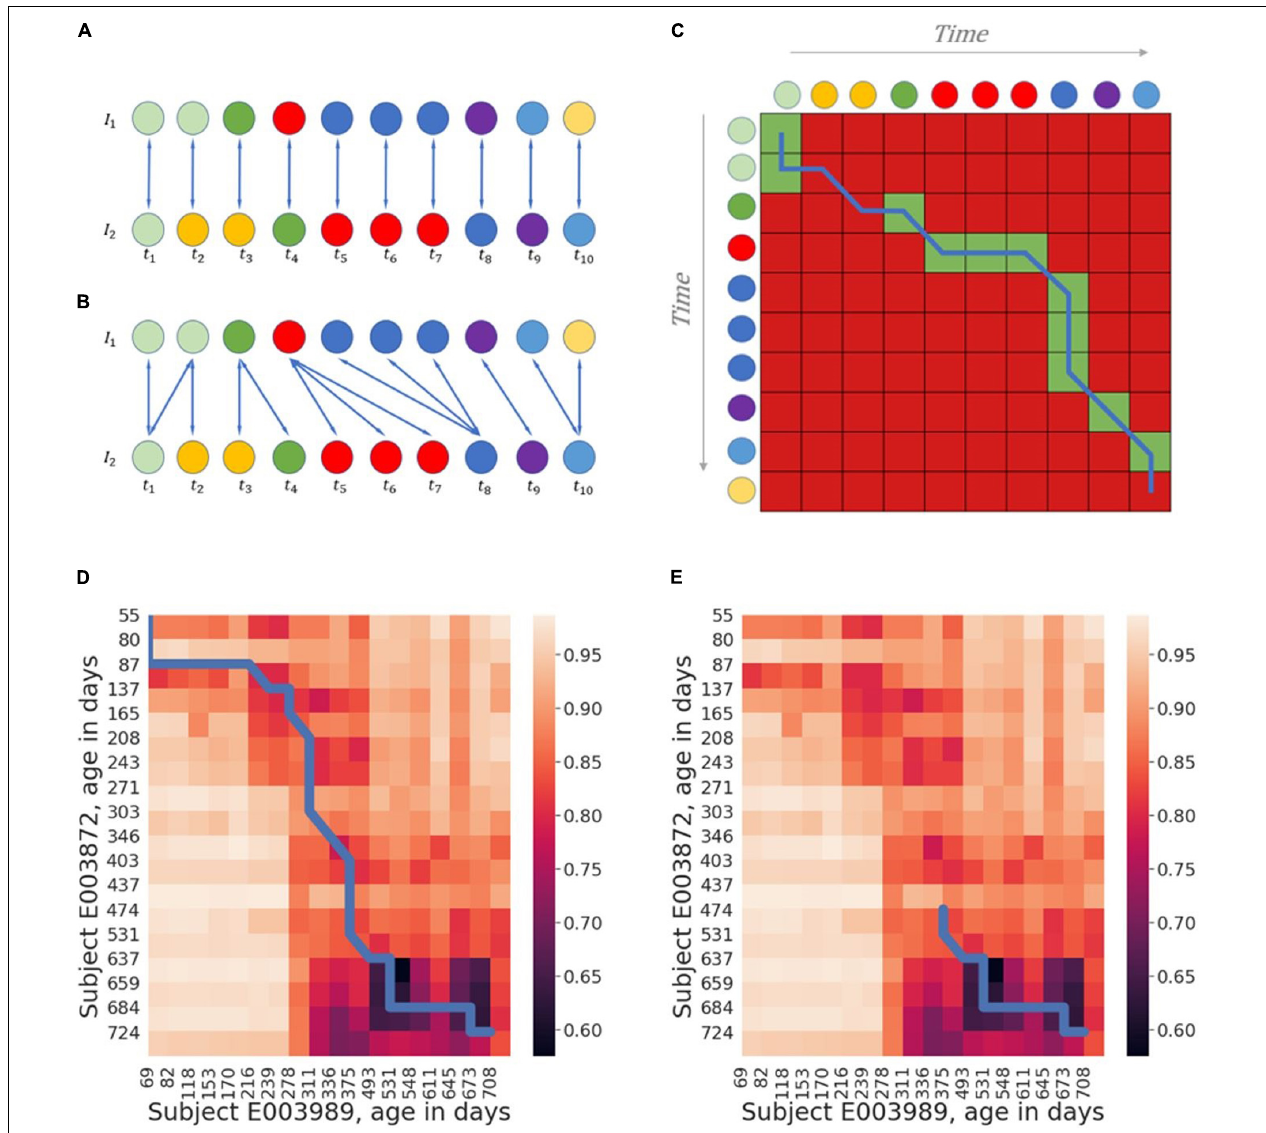
FIGURE 1 | A schematic example of the temporal alignment framework. (A) A naïve matching of chronologically parallel samples. Top and bottom sequences of circles represent trajectories of individuals I1 and I2, with circles of the same color representing samples with similar compositions and circles of different colors represent dissimilar compositions. (B) A mapping that allows the matching of non-parallel samples, resulting in higher total similarity. (C) A heatmap based on the similarities between the samples of the two trajectories. Cells corresponding to similar samples are colored in green, while those corresponding to dissimilar samples are colored in red (for simplicity, we assume here that samples can be either similar or dissimilar whereas in reality, the measure of similarity is usually continuous). The blue line traverses the matches that were presented in panel (B) . (D,E) Example of global (D) and local (E) alignments of real microbiome data. The alignment is denoted again by the blue line, plotted on a heatmap of the pairwise Bray-Curtis dissimilarity between samples obtained from two individuals. Darker areas in the heatmap indicate more similar samples. As can be seen in this figure, the global alignment finds a path traversing the whole matrix while accumulating maximal pairwise similarity, while the local alignment only focuses on the regions with the highest